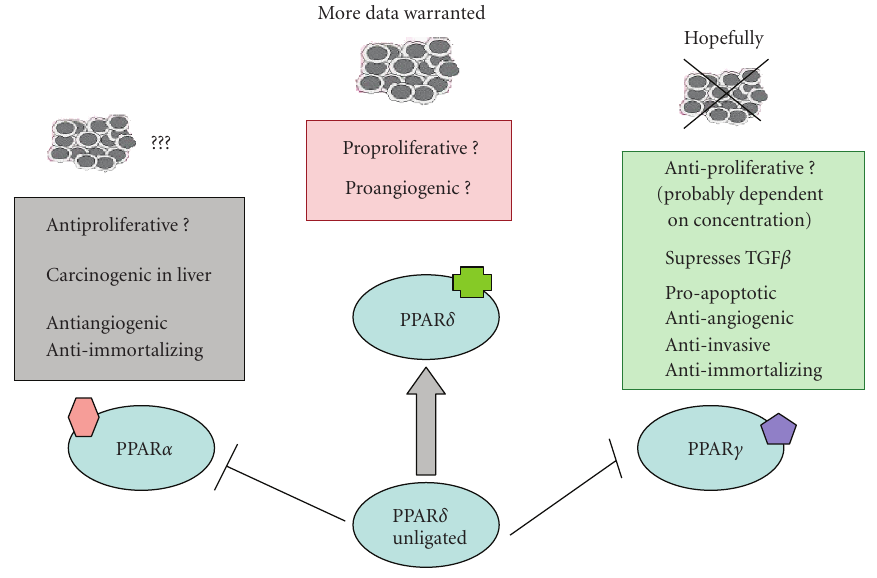
Figure 1: A summary of influence of PPAR ligands on the process of breast